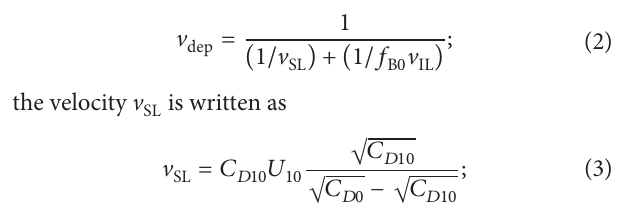
(𝜌 ) , and the ratio between the mass available for uplift and 𝜅 the total mass (𝛾 𝜅 ) are estimated [19], as summarized in Table